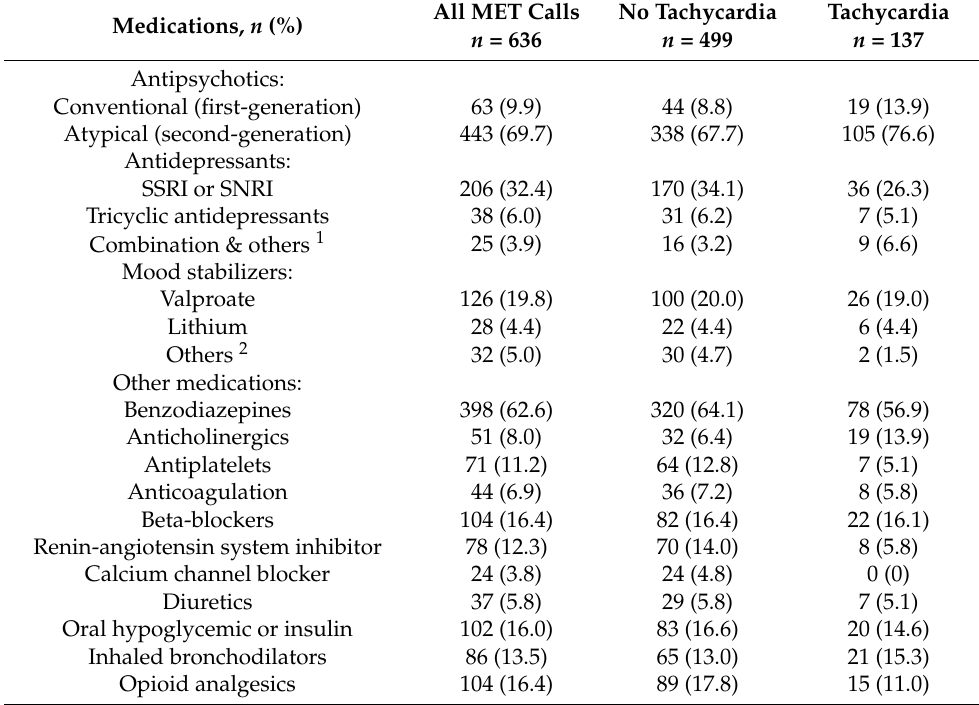
Table 2. Psychotropic and other medications used at the time of the Medical Emergency Team call. Medications, n (%)